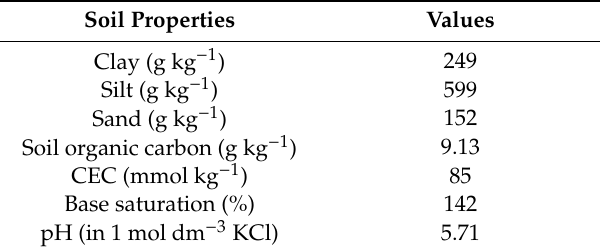
Table 1. Characteristics of a Haplic Luvisol at Doln á Malanta before the